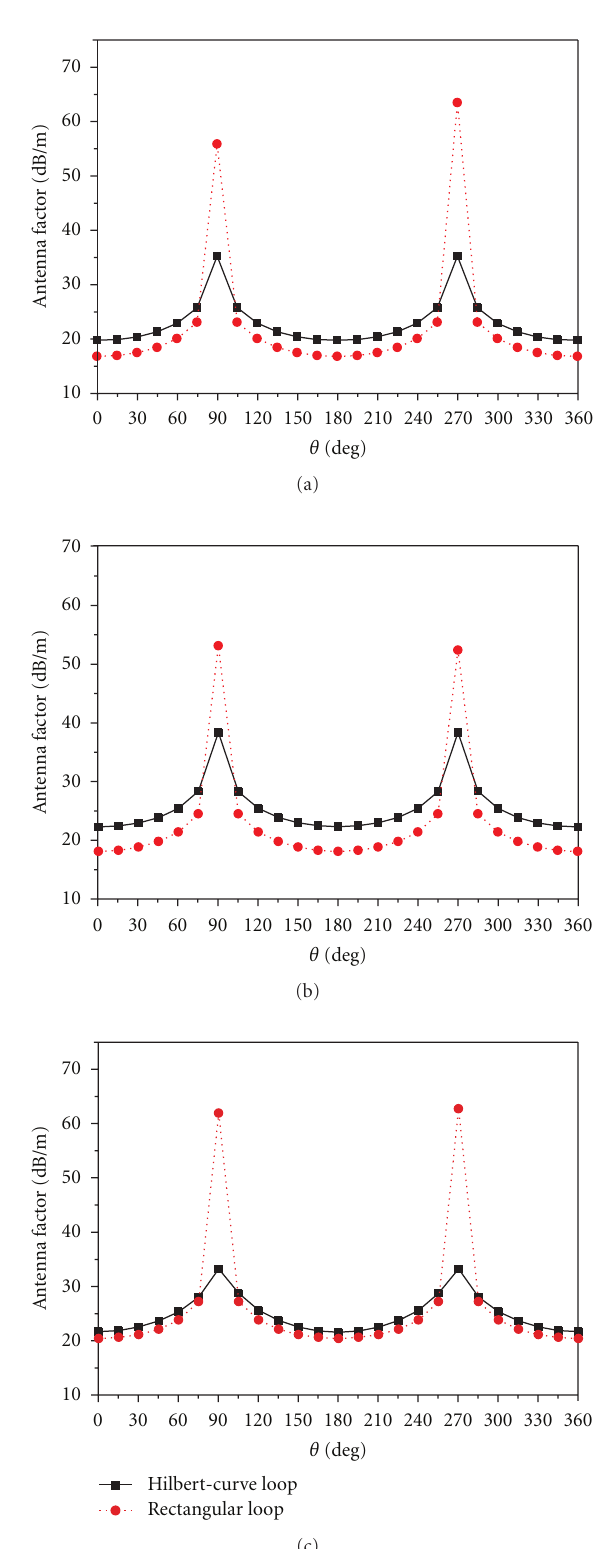
Figure 12: Variation of the antenna factor K at φ = 0 ◦ ( xz -plane) for the proposed flexible Hilbert-curve loop antenna and rectangular loop antenna. (a) 2.45 GHz, (b) 3.35GHz, and (c) 5.5